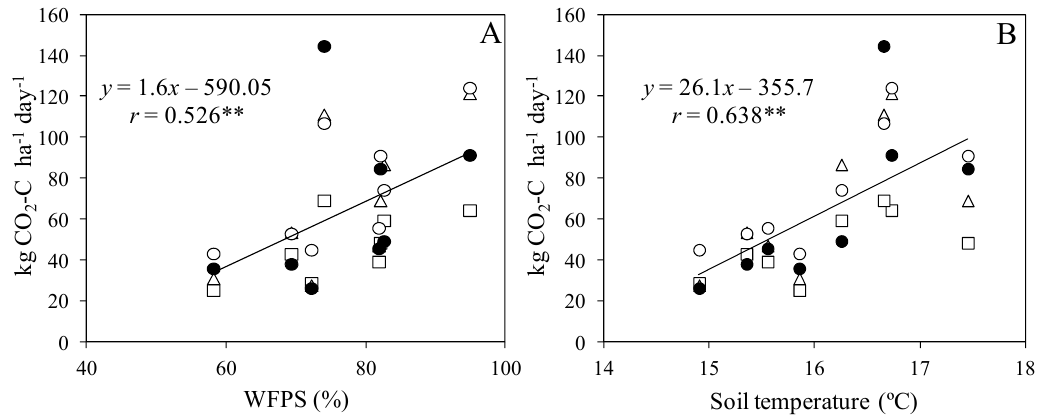
Figure 2. Daily CO 2 emissions for the different treatments related to WFPS ( A ) ( p = 0.002) and soil temperature ( B ) ( p = 0.000). Unfertilized ( □ ), urea ( △ ), ASN ( ○ ), and ASN+DMPP ( ● ).